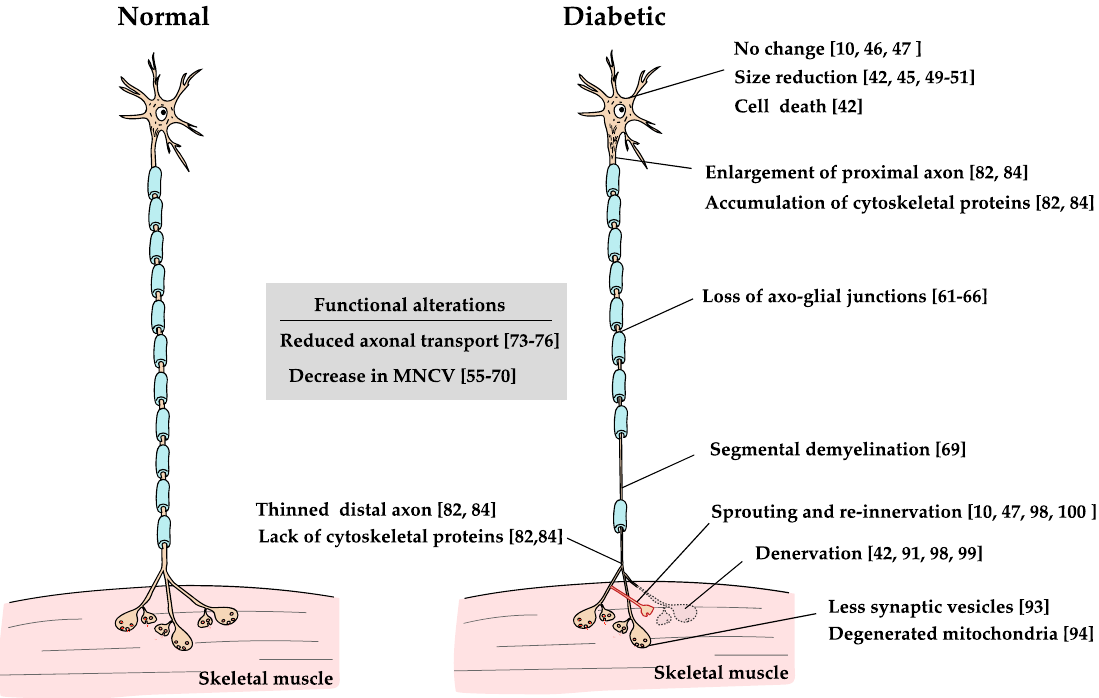
Figure 3. Effects of diabetes on MNs. The effects of diabetes on MNs lead to changes in various parts of the neurons [10,42,44–46,48–50,54–69,72–75,81,83,90,92,93,97–99]. The changes are axon length-dependent neuropathy, which is similar in many ways with DRG neurons.